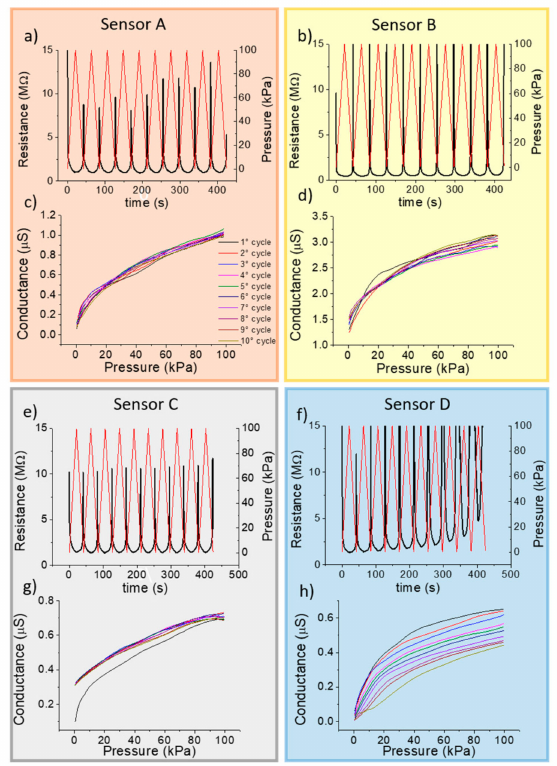
Figure 5. Comparison of the four fabrics. ( a , b , e , f ) Resistance sensor response in dynamic mode for 10 cycles with an applied pressure from 0 to 100 kPa with a frequency of 5 kPa / s. ( c , d , g , h ) Conductance trend during compression for every single